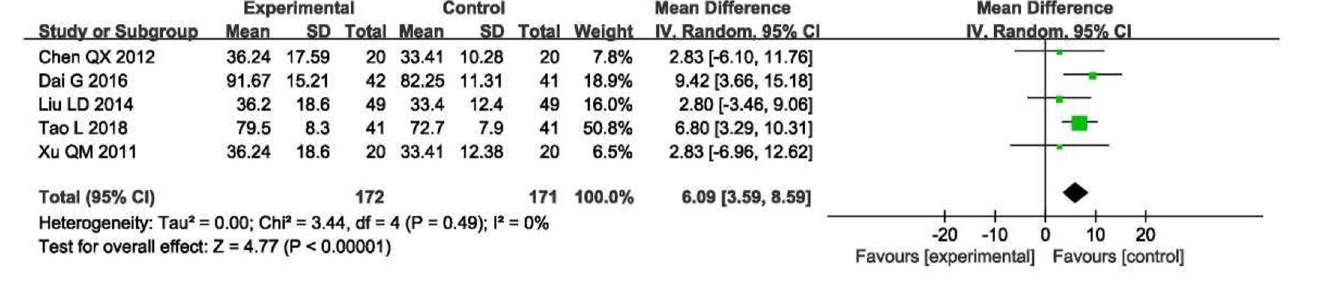
Fig 8. Forest plot of